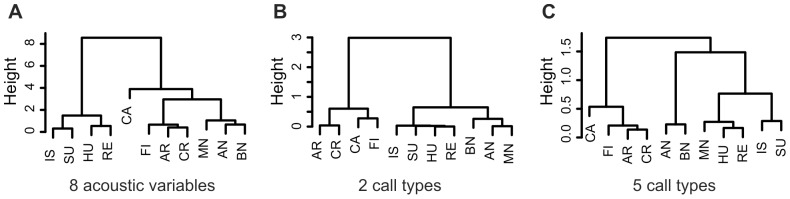
Dendrograms of situation similarity according to A. acoustic parameters, B. two call types and C. five call types.Hierarchical clustering with Ward’s method was used to construct the dendrograms. Height represents cophenetic distance (dissimilarity) between the situations. Distances are estimated by Ward’s criterion for group fusion. AN = after nursing, AR = in the arms of a person, BN = before nursing, CA = castration, CR = crushing, FI = fighting, HU = huddling, IS = isolation, MN = missed nursing, RE = reunion with the sow and litter, SU = surprise.